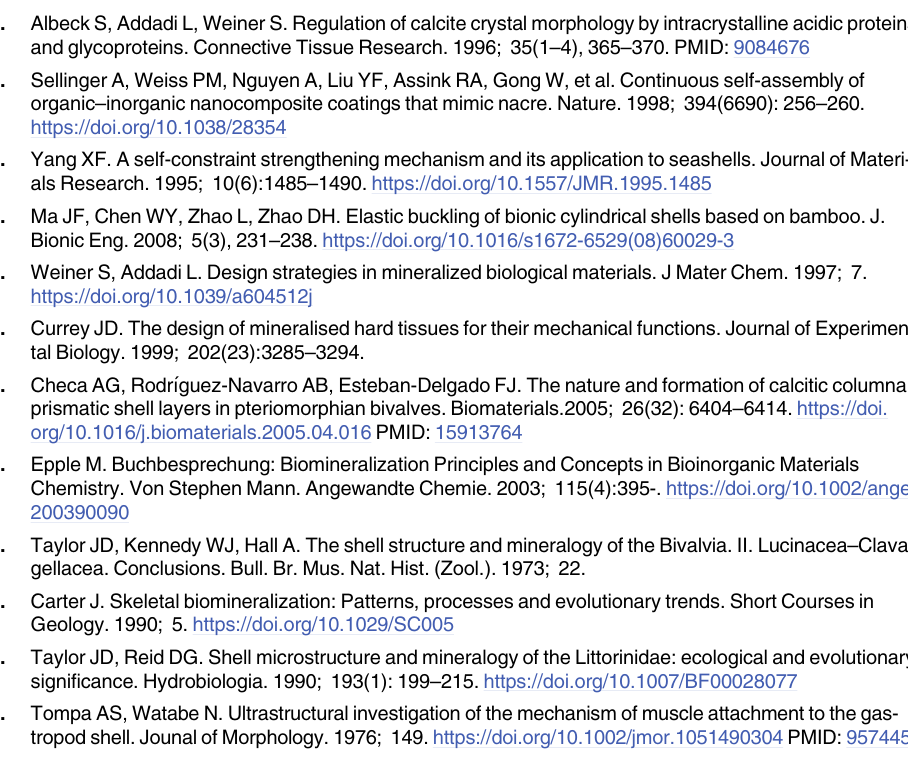
S2 Table. 147 proteins identified with FDR < 0.01 from the acid-insoluble samples of myos- tracum layer of P . viridis shell. S3 Table. 204 proteins identified with FDR < 0.01 from the acid-soluble samples of nacre layer of P . viridis shell. S4 Table. 277 proteins identified with FDR < 0.01 from the acid-insoluble samples of nacre layer of P . viridis